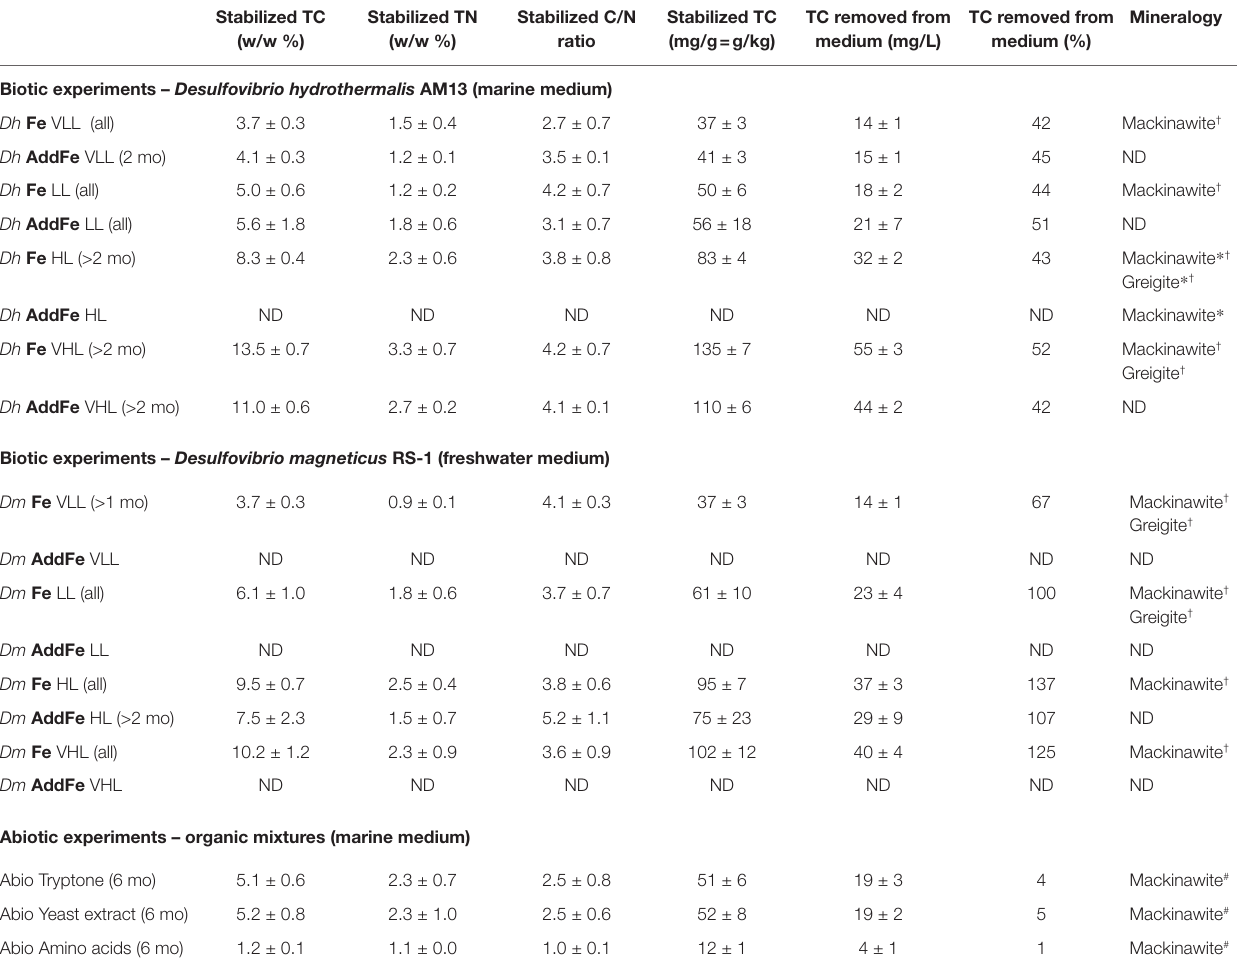
TABLE 3 | Summary of parameters characterized in iron sulfide minerals: total carbon (TC) content (% w/w), total nitrogen (TN) content (% w/w), C/N ratio, TC content (mg/g mineral), TC sequestered from medium (mg/L and %), and